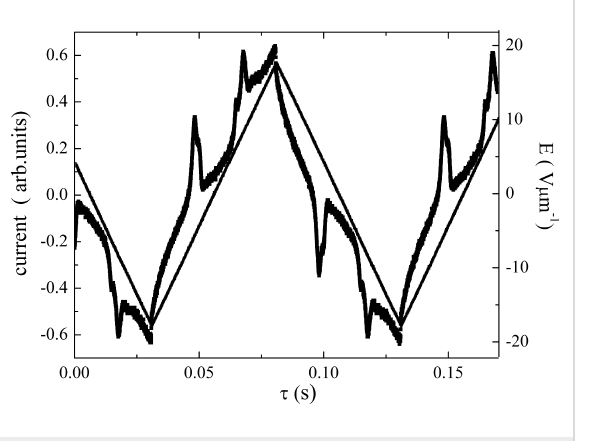
Figure 8: Temperature dependence of the layer spacing value, d , and intensity of the corresponding X-ray signal, int., for IIb .